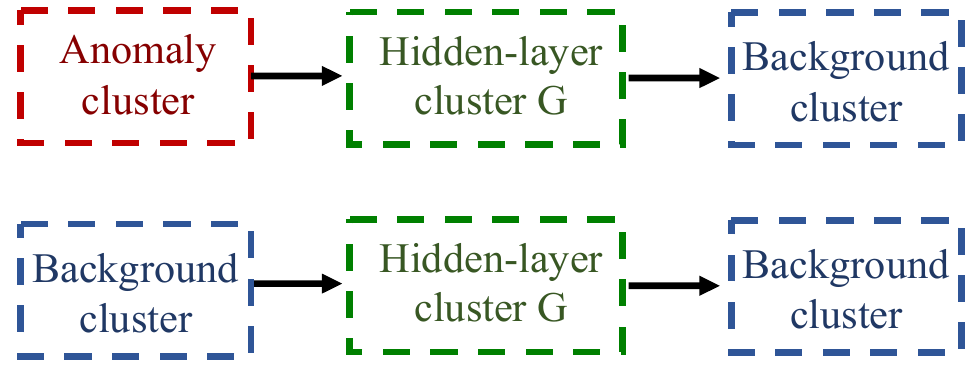
Figure 3. Reconstruction process of AAE in hyperspectral